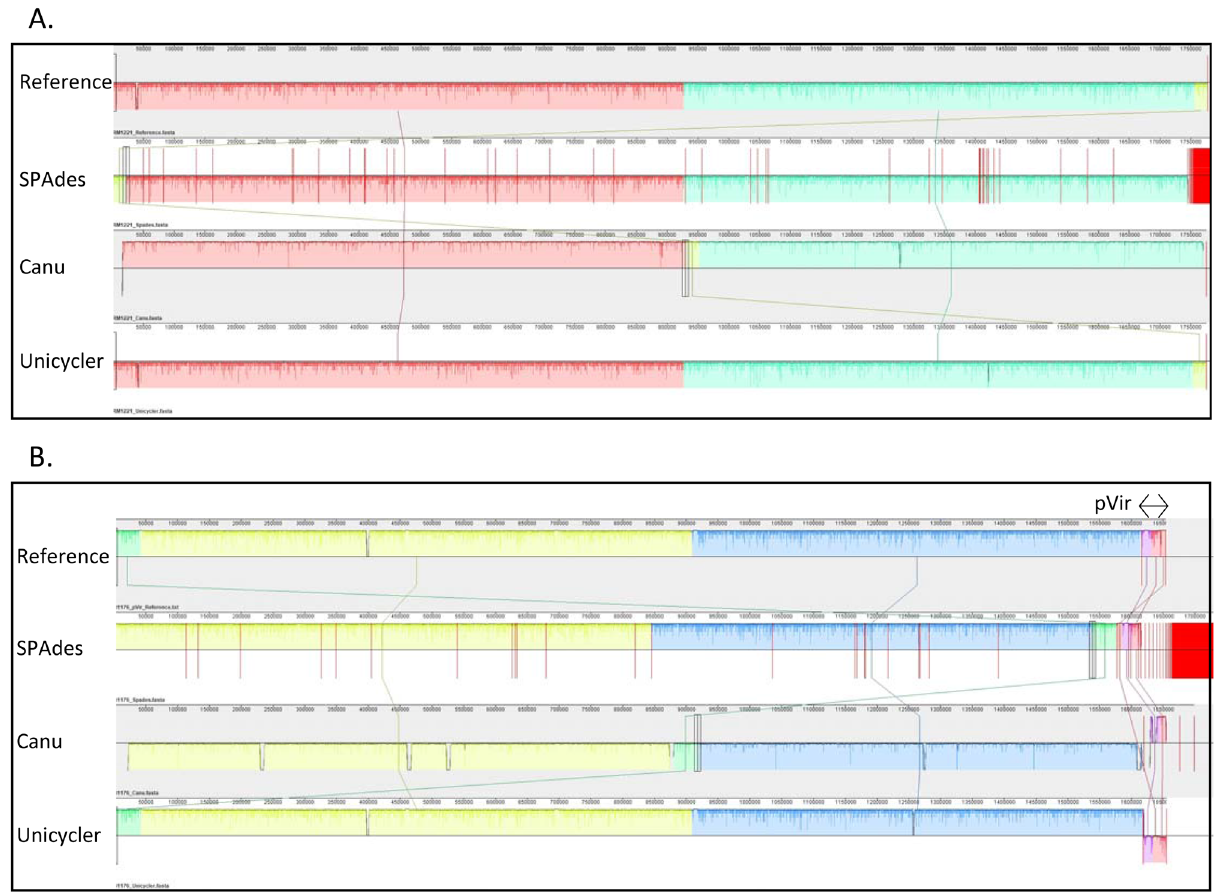
Figure 3. Alignment of Reference Strain Genome Assemblies. The reference genome, SPAdes assembly, Canu Assembly, and Unicycler Assembly for strains RM1221 (Panel A ) and 81-176 (Panel B ) were aligned using the ProgressiveMauve alignment tool. The assembly contigs were ordered according to the reference genome. The colored blocks represent homologous regions and the nucleotide identity is represented as a graph within the blocks. Vertical red lines denote contig boundaries. The C. jejuni 81-176 reference contig containing the pVir plasmid sequence is labeled with a double-side